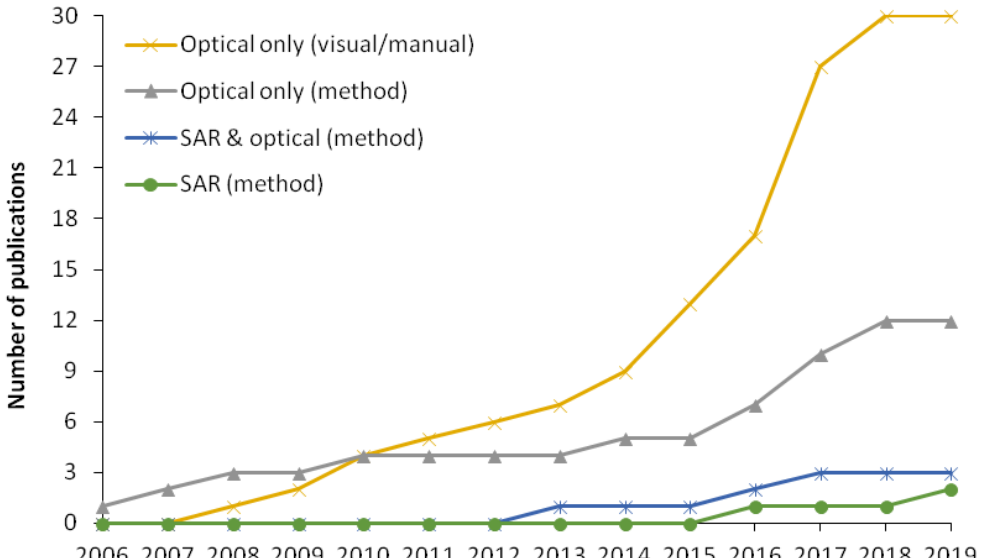
Figure 18. Peer-reviewed publications indexed in Scopus as of June 2019, distinguished based on type of satellite images used (either optical or synthetic aperture radar, SAR) and the mapping approach adopted: visual and manual, or assisted by an image processing-based method.